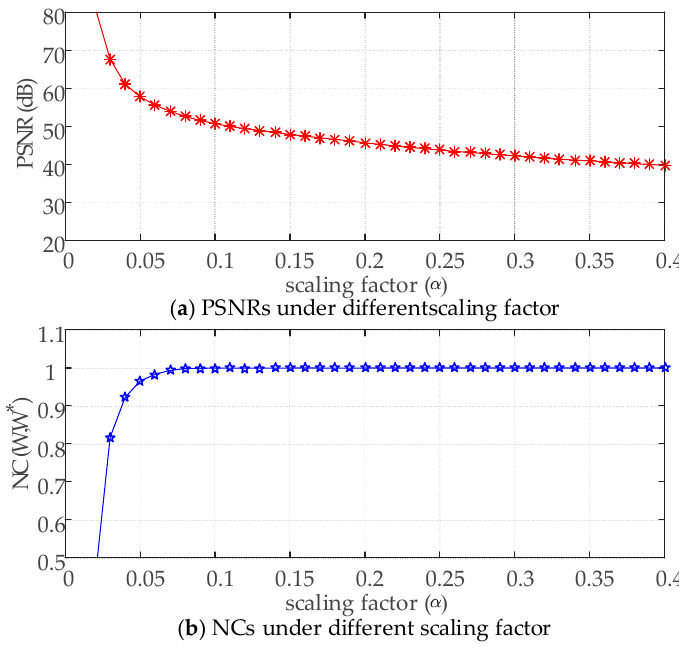
Figure 5. PSNRs and NCs under different scaling factors.